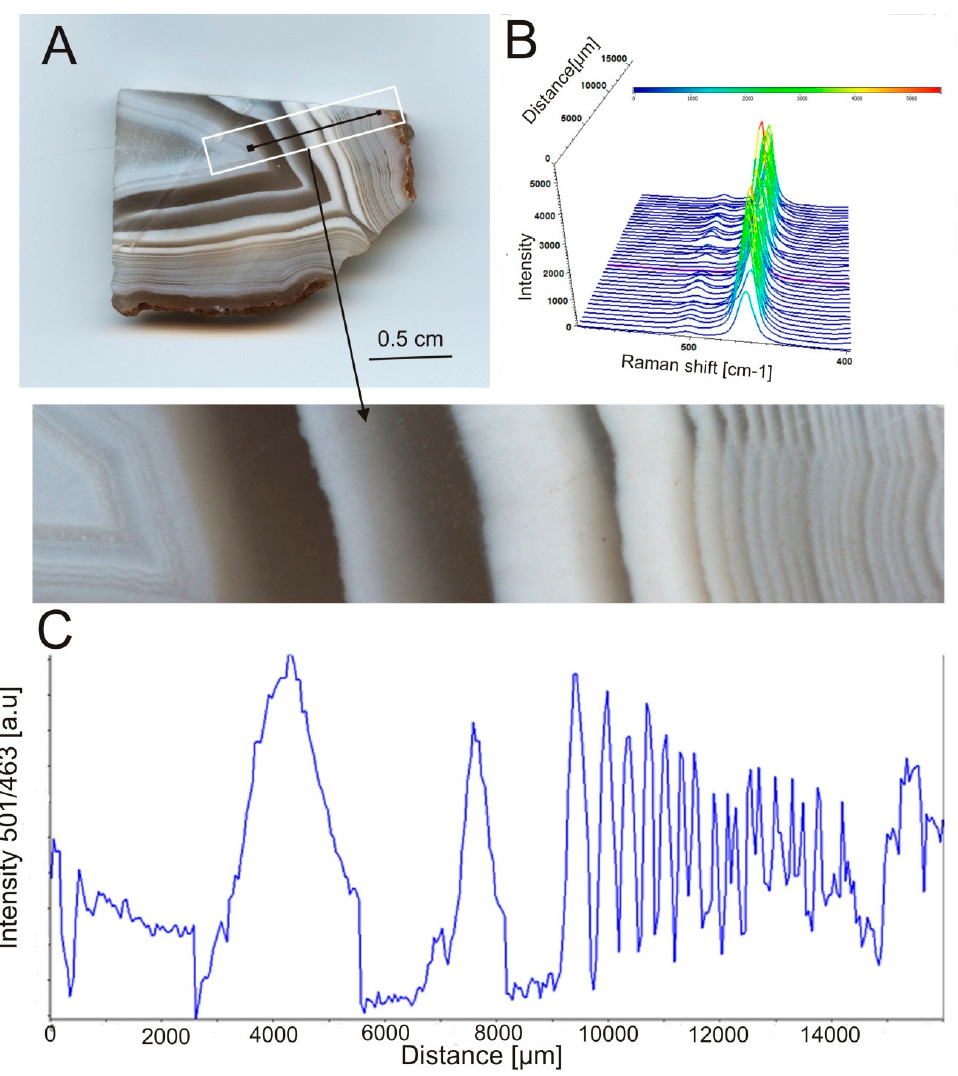
Figure 5. 3D ( B ) plots of micro-Raman line map of monocentric agate nodule from the center core towards the outer rim ( A ) with a diagram showing the ratio of the 501/463 intensities based on peak area measurements along the scan line ( C ).